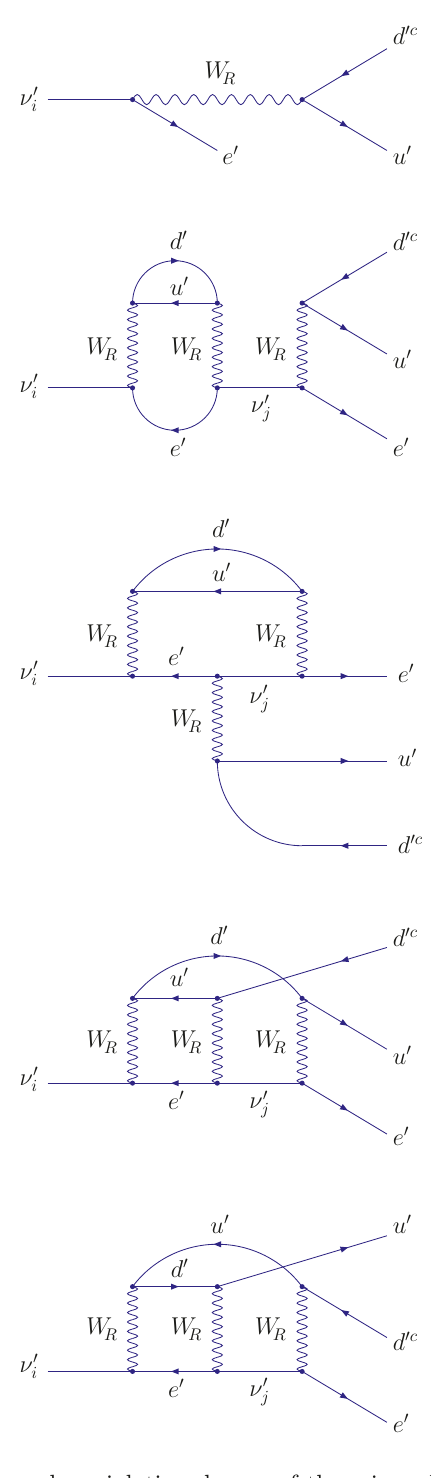
Figure 1 . The lepton-number-violating decays of the mirror Majorana neutrinos into the mirror charged fermions. The CP-conjugate processes are not shown for